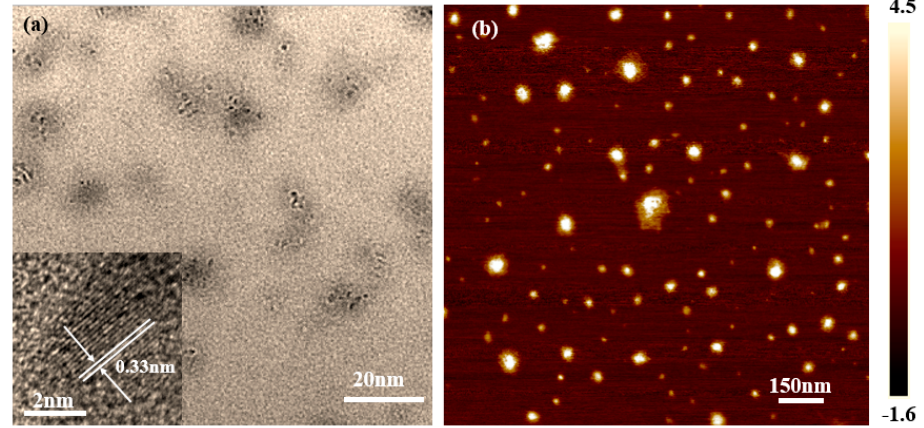
Figure 1. ( a ) TEM of N-L-CQDs. Inset: the HR-TEM of N-L-CQDs. ( b ) AFM photograph of N- L-CQDs.